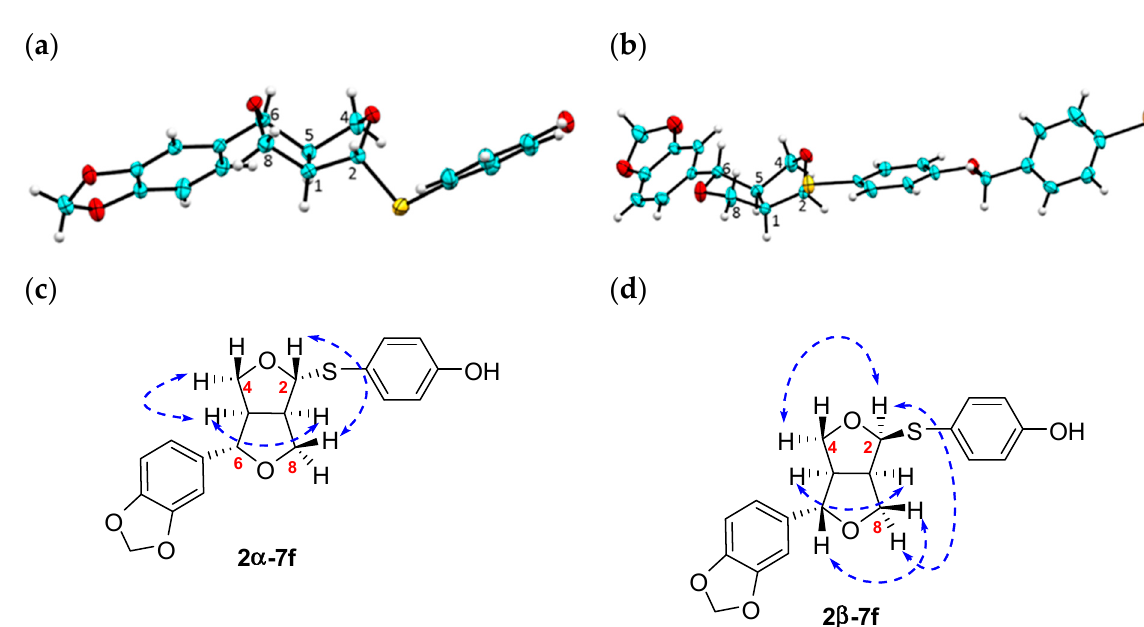
Figure 2. 1 H NMR spectra of 2 α -7f ( top ) and 2 β -7f ( bottom ).